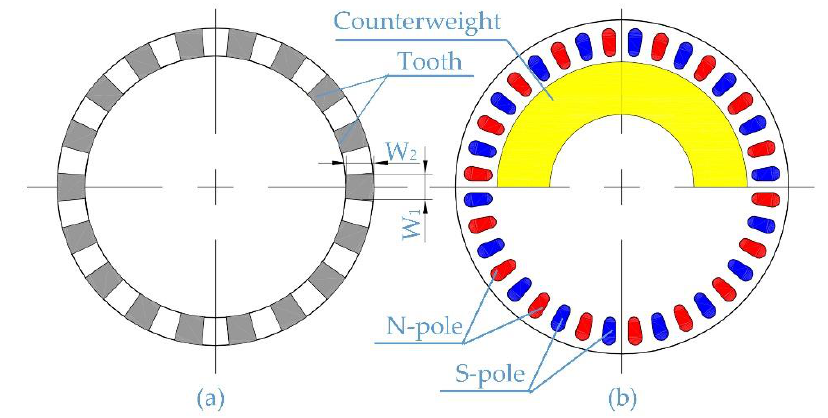
Figure 4. Axial view of the two components: ( a ) Tooth ring; ( b ) Counterweight disc.